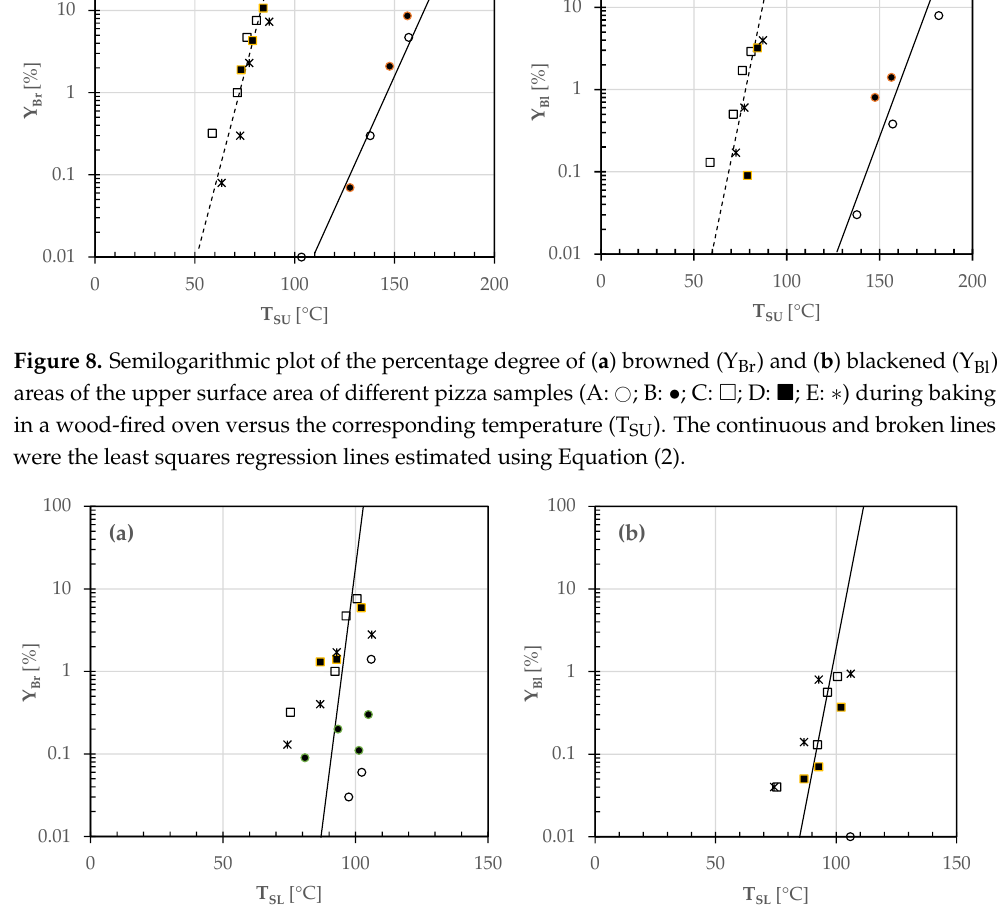
Figure 9. Semilogarithmic plot of the percentage degree of ( a ) browned (Y Br ) and ( b ) blackened (Y Bl ) areas of the lower surface area of different pizza samples (A: ; B: • ; C: (cid:3) ; D: (cid:4) ; E: ∗ ) during baking in a wood-fired oven versus the corresponding temperature (T SL ). The continuous lines were the least squares regression lines estimated using Equation (2).